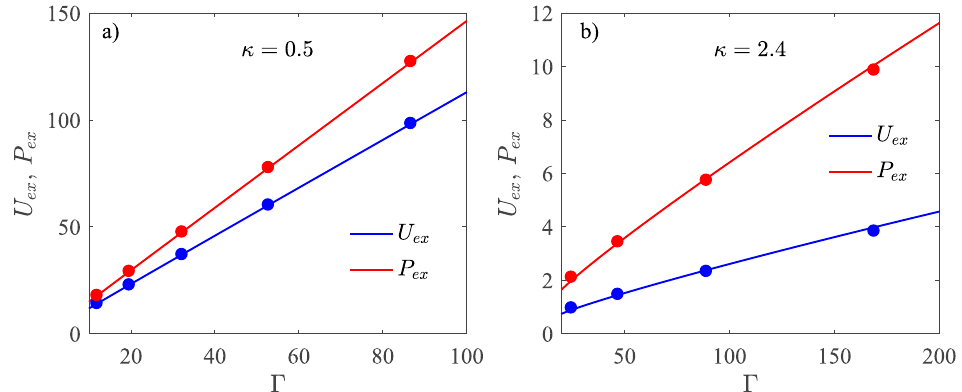
Figure 1. Dependence of the reduced excess internal energy U ex and the reduced excess internal pressure P ex on the coupled parameter Γ for the values of the screening parameter κ = 0.5 ( a ) and κ = 2.4 ( b ), which are constructed using expressions (13) and (15). Symbols show data from work [20]. Table 2. Longitudinal sound velocity in units of thermal velocity c L of a 2D Yukawa fluid, found ( 2st ) using g ( x ) from MD simulations. The same value c calculated based on the expression L